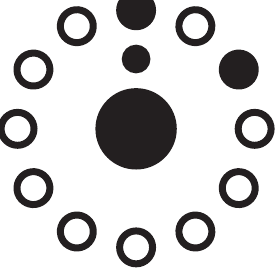
Figure 1. The coded mark points in this paper.